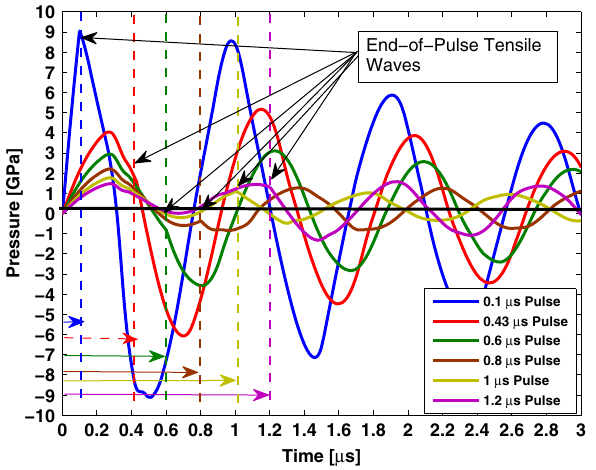
FIG. 11. Same analysis as in Fig. 10 but showing the pressure derivative for different pulse lengths. The influence of the end-of-pulse can be seen in the drop of the pressure derivative at the end of the pulses. It can be easily seen as well that, except on case of 0 . 1 μ s length, these discontinuities in pressure derivative are more accentuated when the wave is going to tensile states, i.e. DP=Dt < 0